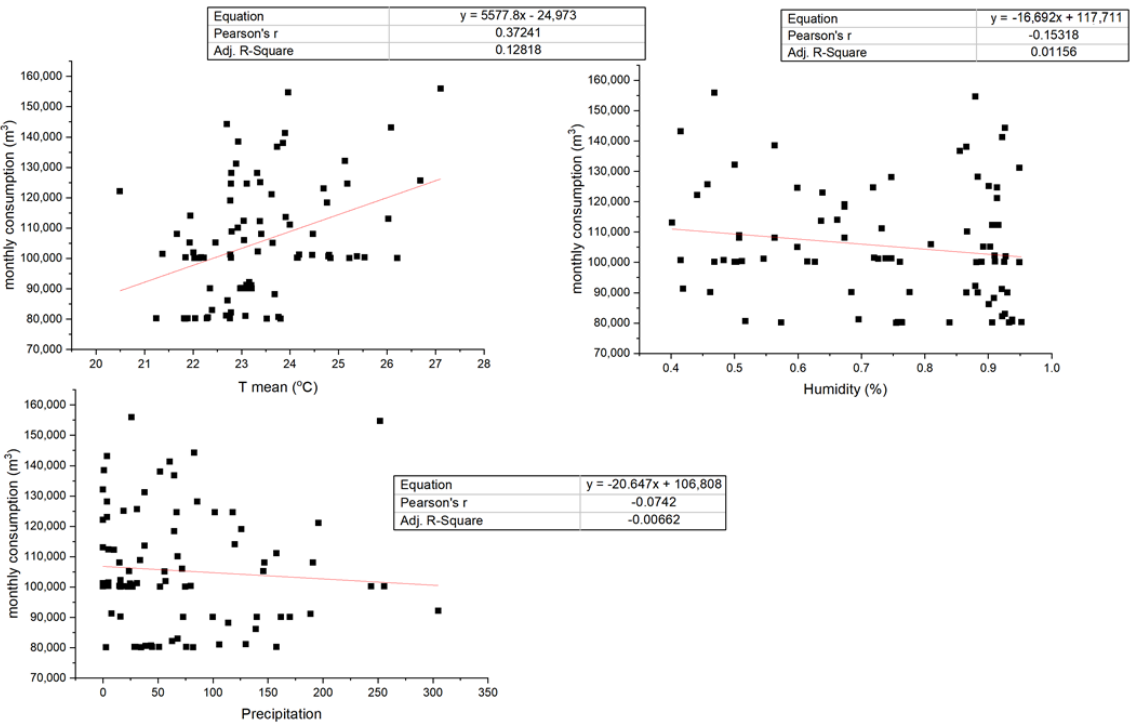
Figure 8. Monthly water consumption trendline of the climate variables of Arba Minch (2012 – 2020).